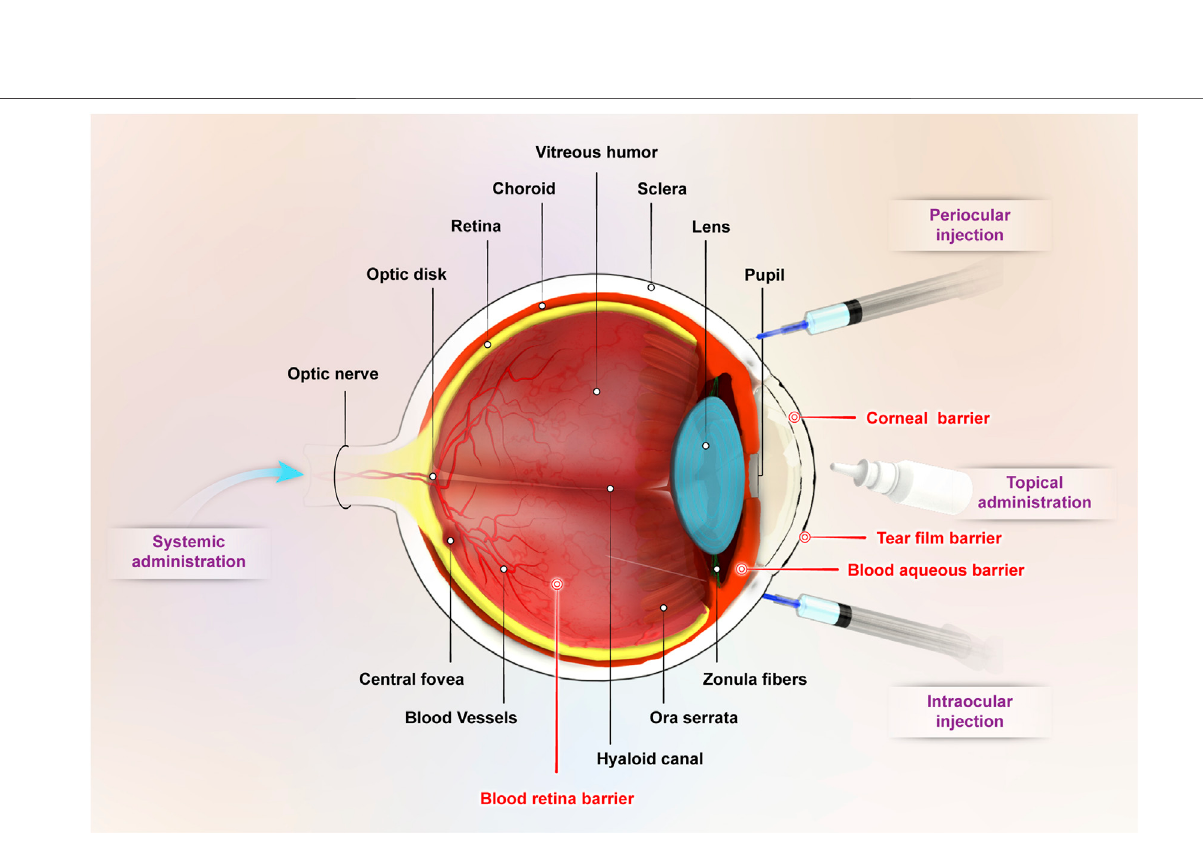
Frontiers in Chemistry |